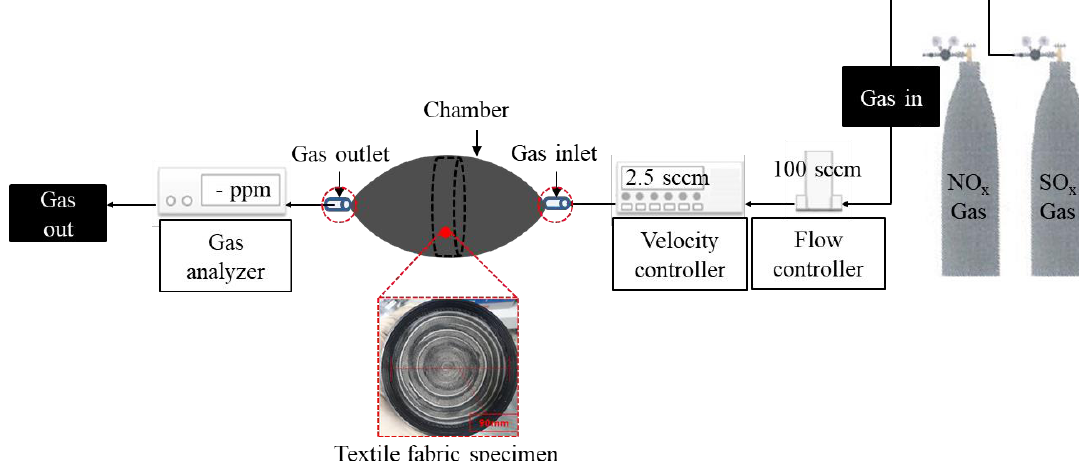
Figure 5. Machine for measuring SO x and NO x removal by the textile fabric.